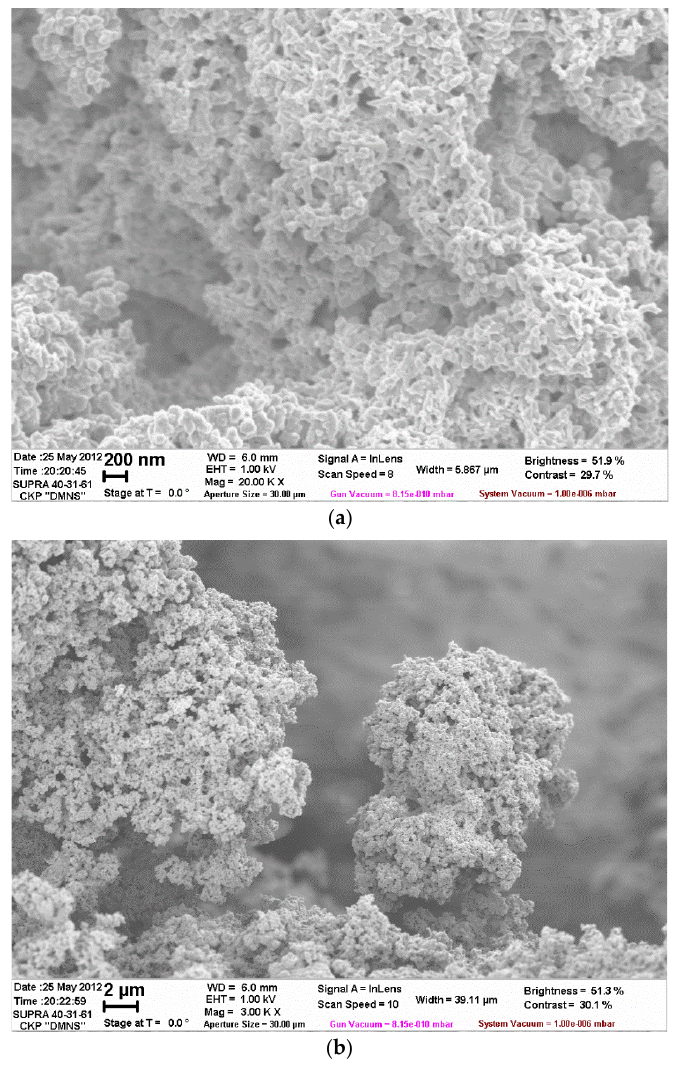
Figure 5. SEM image of core/shell pigment with a talc core and H 2 SO 4 -doped PANi shell ( a )—3000× magnification, ( b )—20,000× magnification). The FTIR spectra of different core/shell pigments and PANi samples are shown in Figure S1 (Supplementary Materials). The absorption bands at 1478 cm − 1 and 1560 cm −1 are assigned to benzenoid and quinoid ring vibration, respectively [38]. The absorption band characteristic of the conducting protonated form is found at about 1245 cm −1 . The absorption band at 1139 cm −1 is due to the in-plane bending vibration of C–H [39], while at 1305 cm −1 it is because of C–N stretching of the benzenoid ring of PANi [40]. The aro- matic ring and out-of-plane C–H deformation vibrations manifest themselves in the re- gion of 900–700 cm −1 . The FTIR spectra of core/shell pigments show a blue shift of the main absorption bands, compared to PANi. Besides, from absorption bands caused by PANi presence, there are a number of bands in the spectra of core pigments related to the core used in the study. For kaoline: 3692 cm −1 , 3666 cm −1 , and 3653 cm −1 —O-H stretching vibra- tions of inner surface hydroxyl bands, 3620 cm −1 —O-H stretching vibrations of inner hy- droxyl bands, 1115 cm −1 —Si-O stretching vibrations, 1032 cm −1 and 1010 cm −1 —in-plane Si-O stretching vibrations, 914 cm −1 —O-H deformation of inner hydroxyl bands, 787 cm −1 —Si-O stretching vibrations, 753 cm −1 —Si-O stretching vibrations, 541 cm −1 —Al-O-Si deformation vibrations, and 471 cm −1 —Si-O-Si deformation vibrations (Figure S1b). For talc: 3673 cm −1 —vibrations of hydroxyl groups linked to Mg-OH, 1040 cm −1 and 476 cm −1 — siloxane group (Si-O-Si) stretching vibrational bands, and 677 cm −1 —corresponds to vi- brations Si-O-Mg bond (Figure S1d). For bentonite: 3695 cm −1 —assigned to Al-OH-Al in the mineral, 3620 cm −1 —O-H stretching vibrations of inner hydroxyl bands, 1035 cm −1 — assigned to the degenerate Si-O stretching in-plane vibration, and 913 cm −1 is assigned to OH deformation mode of Al-Al-OH or Al-OH-Al, (Figure S1a). For muscovite: 3695 cm −1 —O-H stretching vibrations of inner surface hydroxyl bands, 3625 cm −1 —O-H stretch- ing vibrations of inner hydroxyl bands, 1115 cm −1 —Si-O stretching vibrations, 1020 cm −1 and 996 cm −1 —in-plane Si-O stretching vibrations, 826 cm −1 —Al-O stretching (Al in tetra- hedral sheet), 747 cm −1 —Al-O-Al stretching (Al in tetrahedral sheet), 532 cm −1 —Al-O-Si deformation vibrations, and 478 cm −1 and 416 cm −1 —Si-O-Si deformation vibrations (Fig- ure S1c). Reflection spectrum has a maximum in the 500–550 nm range for all PANi-shell core/shell pigments (Figure 6). A change in PANi content in core/shell pigment affects the reflection index only and does not lead to a shift in the absorption maximum (Figure 7a).